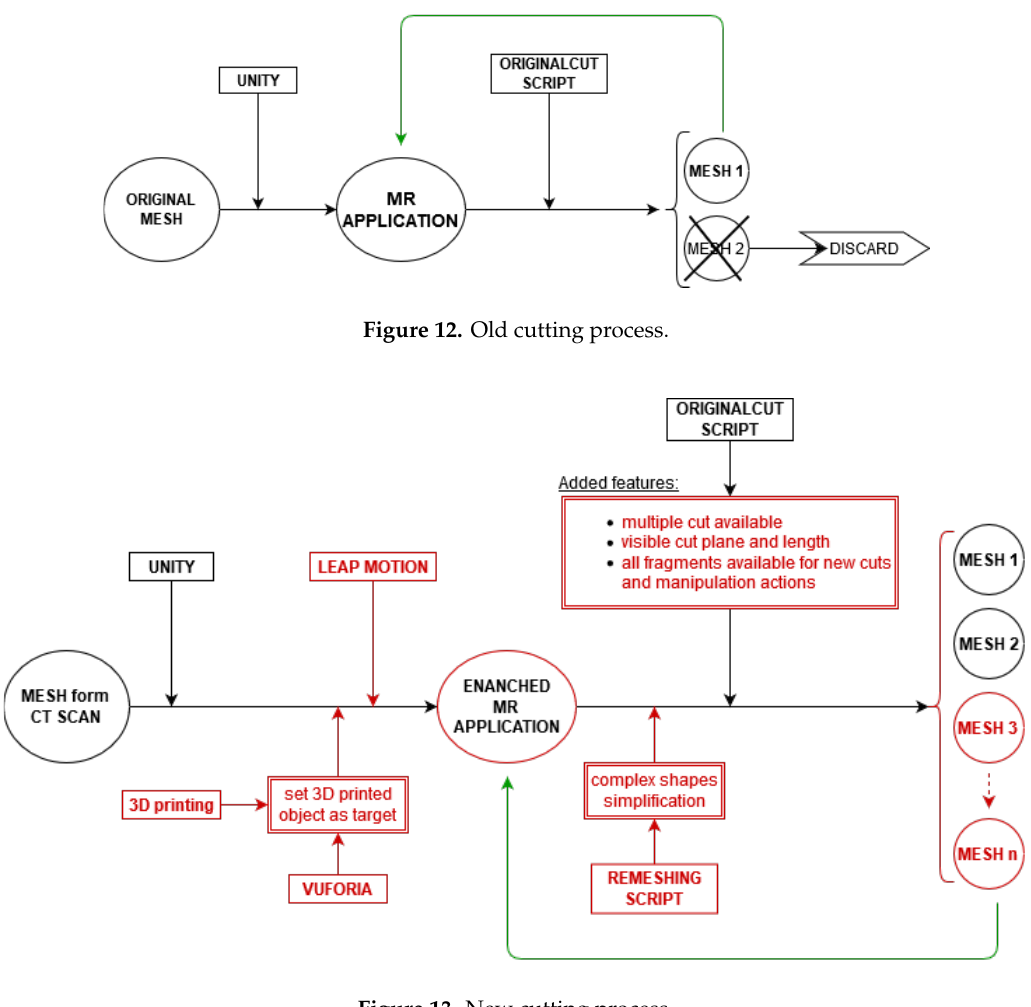
Figure 13. New cutting process.